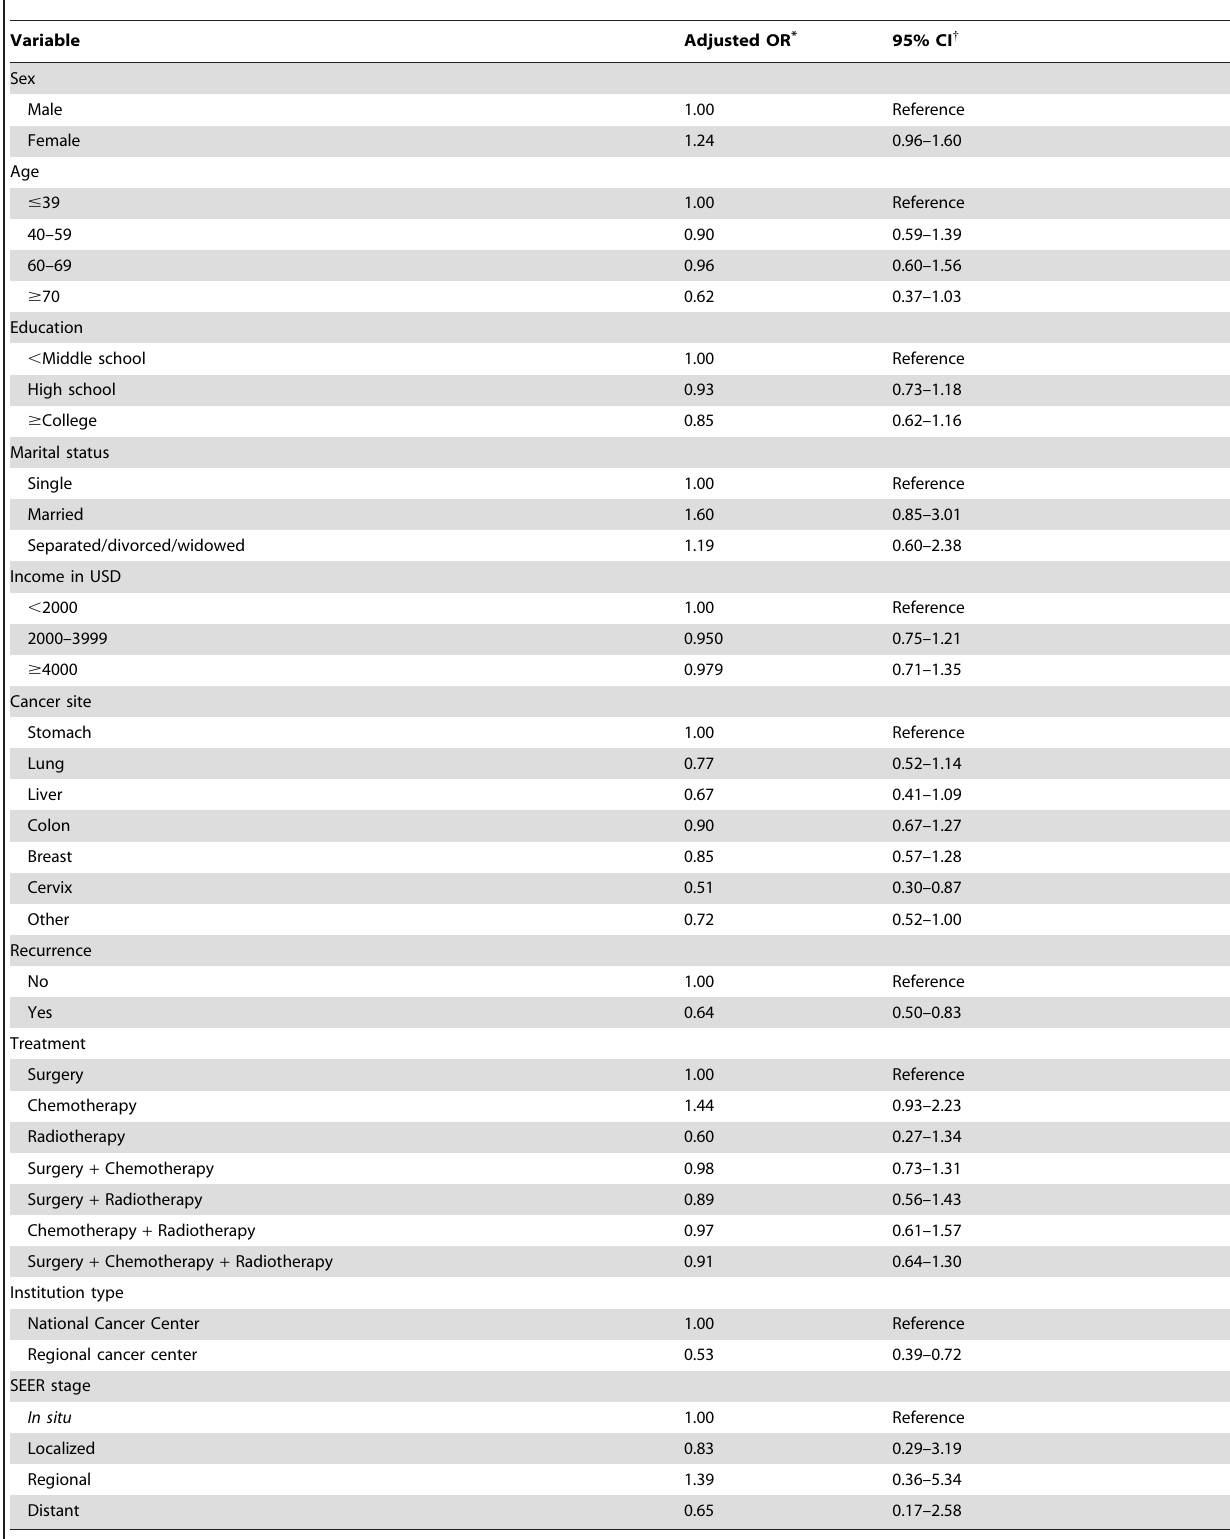
Table 3. Factors associated with incongruent between perceived and actual cancer